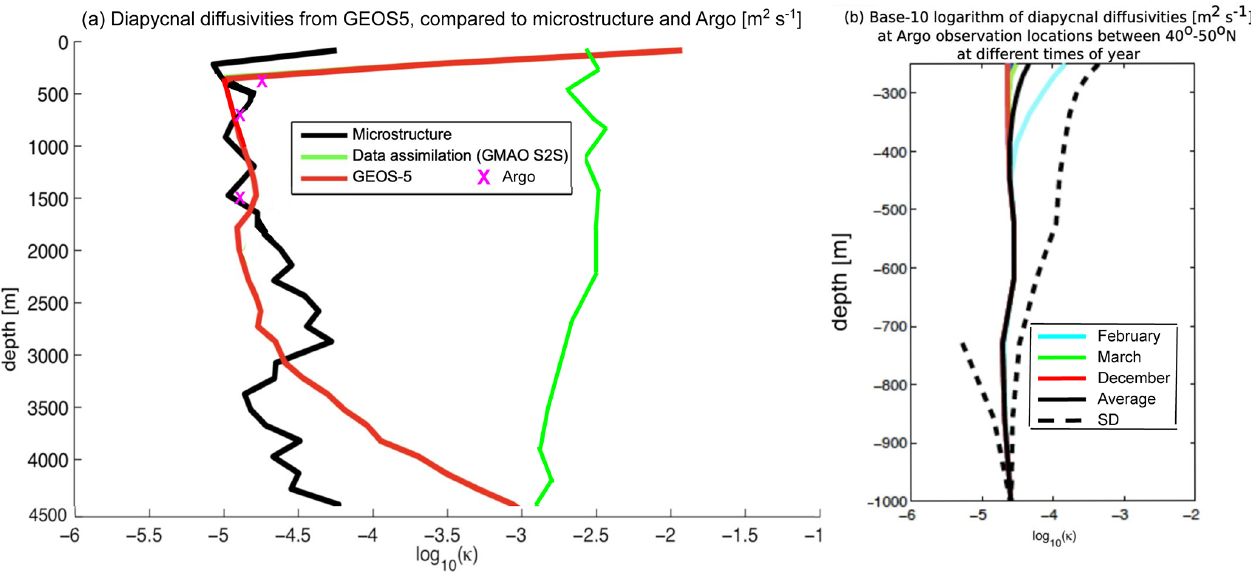
Figure A1. κ ρ profiles (panel a ; units in m 2 s − 1 ) averaged over the full-depth microstructure locations from the observations (black curve) presented in Waterhouse et al. (2014) (see their Fig. 6), the Whalen et al. (2015) Argo-derived product for three depth bins (magenta X marks), the temporally averaged output of a free-running coupled Earth system model simulation (GEOS-5 – red curve), and the temporally averaged output of an equivalent run with data assimilation (GMAO S2S – green curve). Also shown are (panel b ) κ ρ profiles from the free-running GEOS-5 simulation averaged over 40–50 ◦ N in the North Atlantic Ocean and averaged over all January months (lighter colors) and all December months (darker colors). The base-10 logarithms of the geometric averages are shown in each panel.